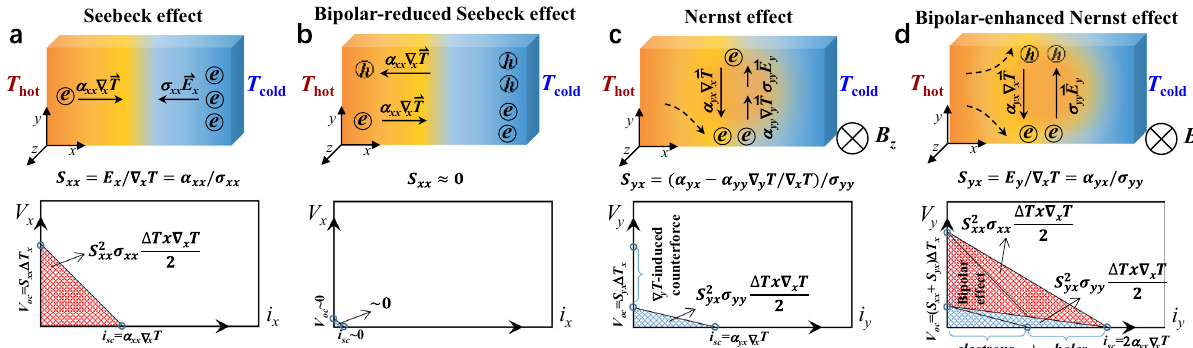
Fig. 2 Bipolar effect on thermoelectricity. Schematic of Seebeck ( a , b ) and Nernst ( c , d ) effects without ( a , c) and with ( b , d ) bipolar effect, from perspectives of internal current fl ow (top) and electric power output (bottom). The half of the product of the short-circuit current ( i sc = α xx ∇ x T , where α is the Seebeck conductivity) and open-circuit voltage ( V oc = S xx Δ T x , where S is the Seebeck conductivity. In longitudinal mode, S equals to α divided by electrical conductivity σ ) represents the maximal electric power output measured by the power factor ( PF ), as indicated by the shaded areas. The bipolar-enhanced PF in ( d ) will be the sum of the twofold Seebeck- PF in ( a ) and the twofold Nernst- PF in ( c ). Note that ( d ) depicts the ideal case of a full compensation of thermal Hall effect for arbitrary materials, which corresponds to a perfectly symmetric conduction and valence bands with the Fermi level locating at the